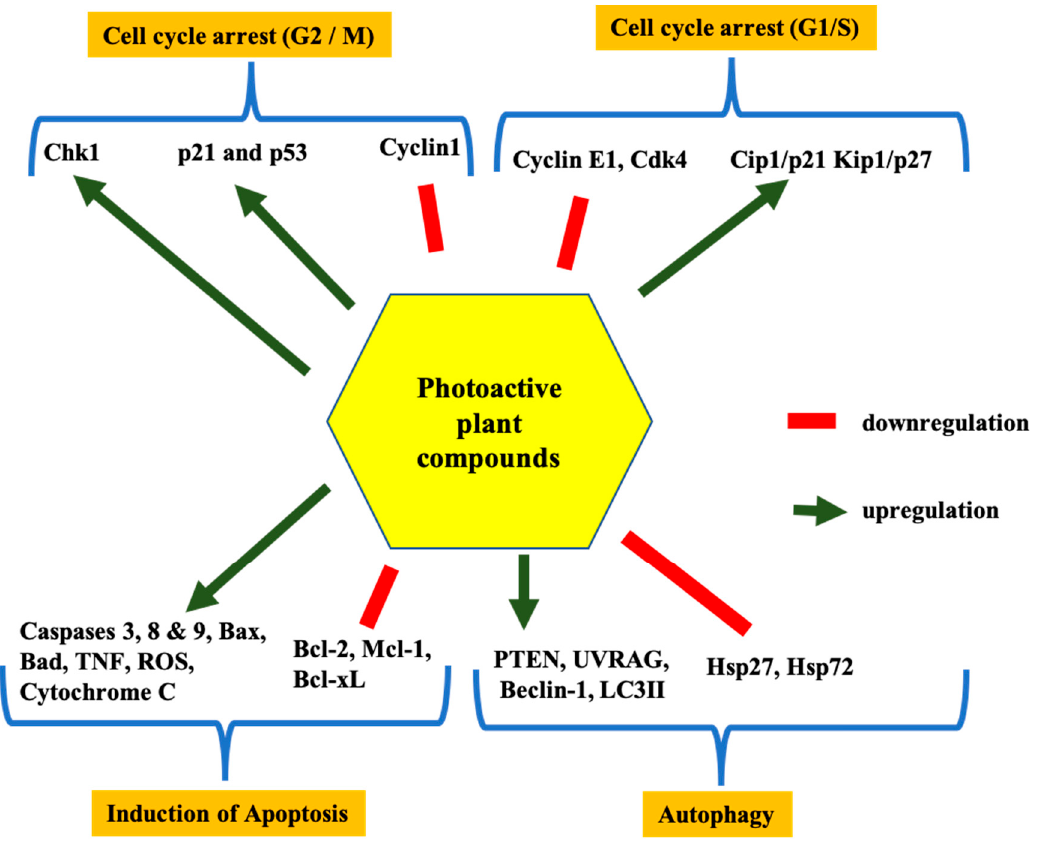
Figure 4. Common molecular targets of major photoactive compounds.